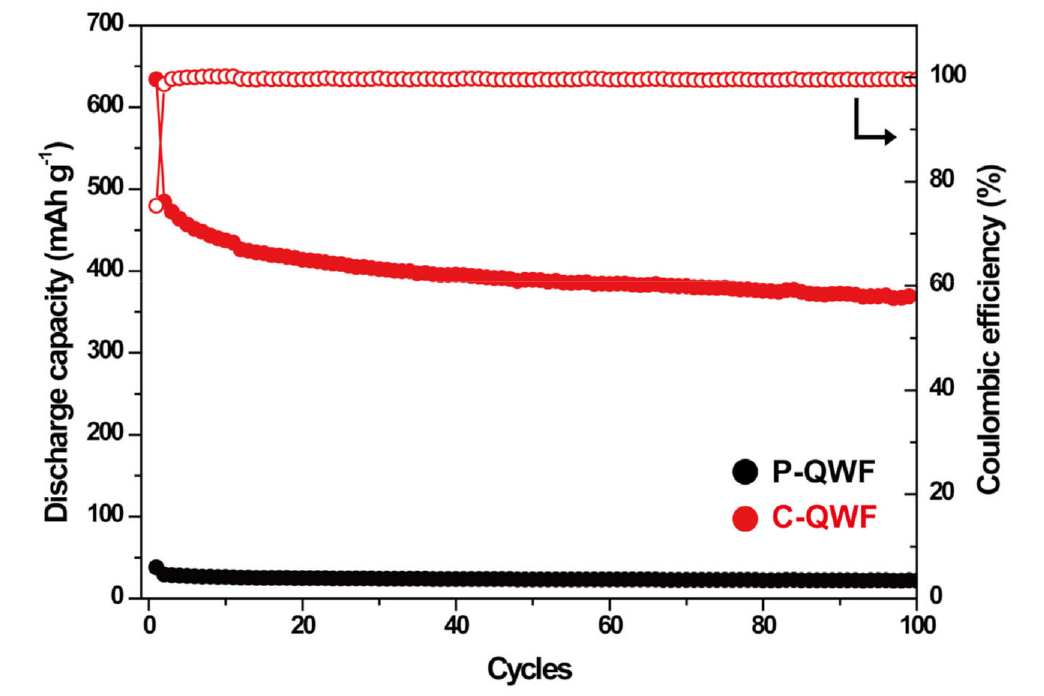
Figure 4. Cycle performances of QWF electrodes at a rate of 0.05 C-rate (red: C-QWF, black: